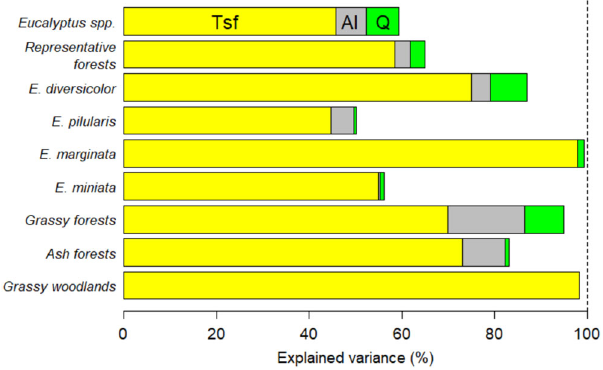
Fig.5|Contributionsofindependentvariablestoexplainedvarianceinbest fi t models. (Table